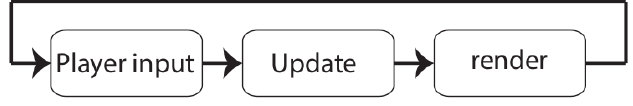
Figure 1. Simple Coupled